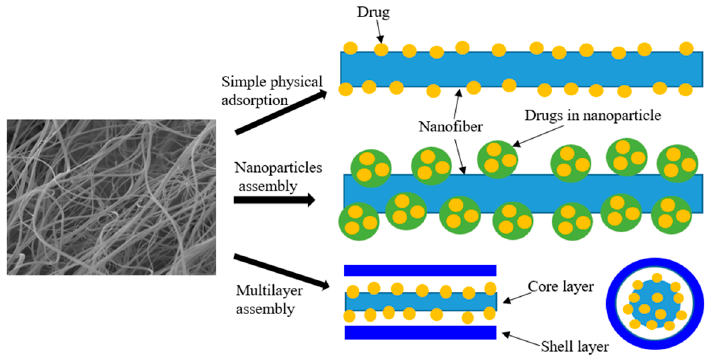
ff erent physical adsorptions of drugs into Figure 11. Three different physical adsorptions of drugs into nanofibers. Figure 11. Three di